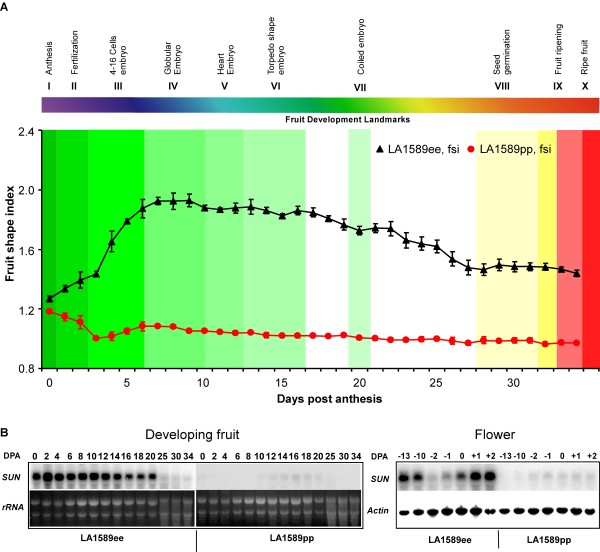
Fruit developmental landmarks superimposed with shape changes controlled by SUN. (A) Fruit landmark stages are color coded and indicated above the graph. Fruit shape index (length/width ratio, Y-axis) is shown as a function of dpa (X-axis). The kinetics of fruit shape change is overlaid on the fruit developmental landmarks. The largest difference in fruit shape indices is achieved at fruit landmark 3 and 4, coinciding with the landmarks 4–16 cell and globular stage of the embryo. Data shown are mean (± se) from three inflorescences per plant and from five plants per genotype. (B) SUN expression in the developing fruit and flowers of LA1589 NILs as determined by Northern blot analysis. Tissues were harvested in days post anthesis (DPA) as indicated above the lanes. LA1589ee carries oval shaped fruit and the sun allele of Sun1642. LA1589pp carries round fruit and the sun allele of LA1589 which is wildtype.